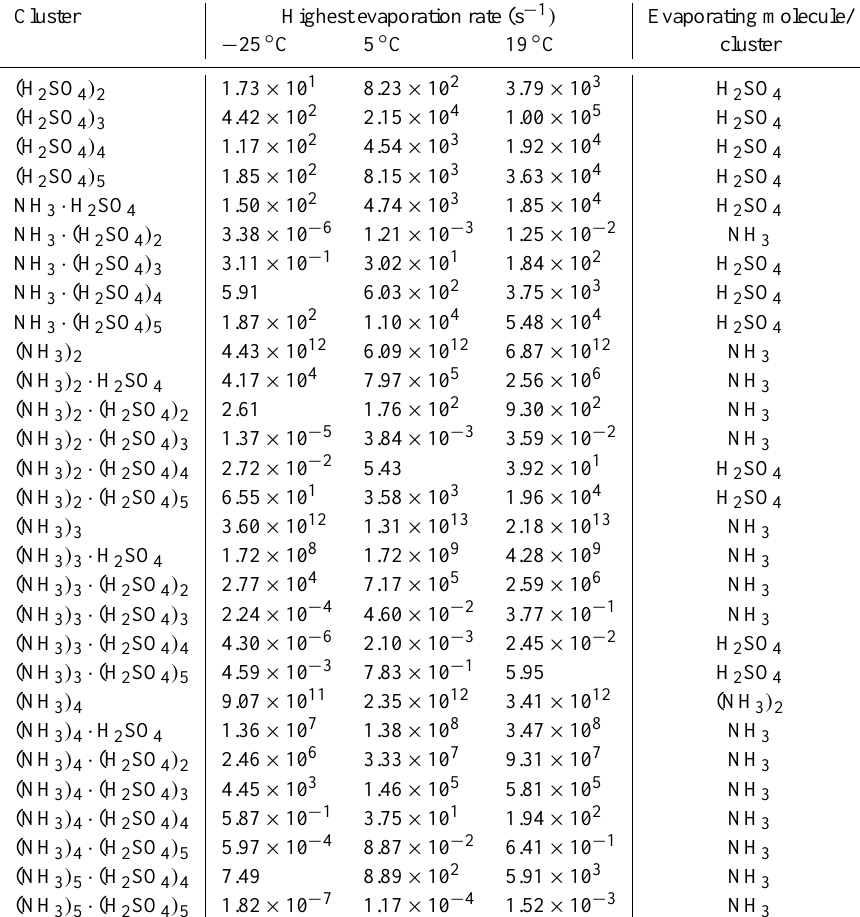
Table 3. Evaporation rates from neutral clusters, used for the ACDC model simulations.